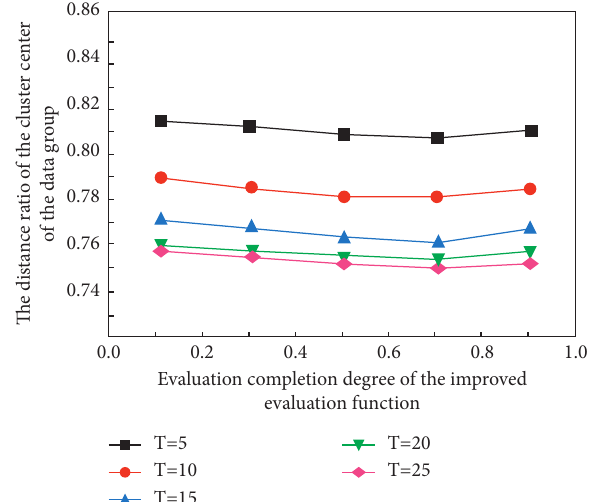
Figure 5: Improved simulation analysis results of evaluation function on data under different threshold